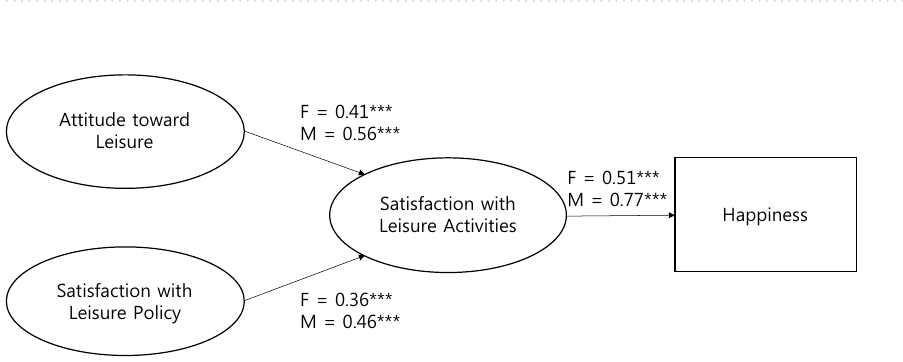
Figure 2. Model with equality constraints on factor loadings and path coefficients (standardized coefficients are shown for females and then males: *** p <